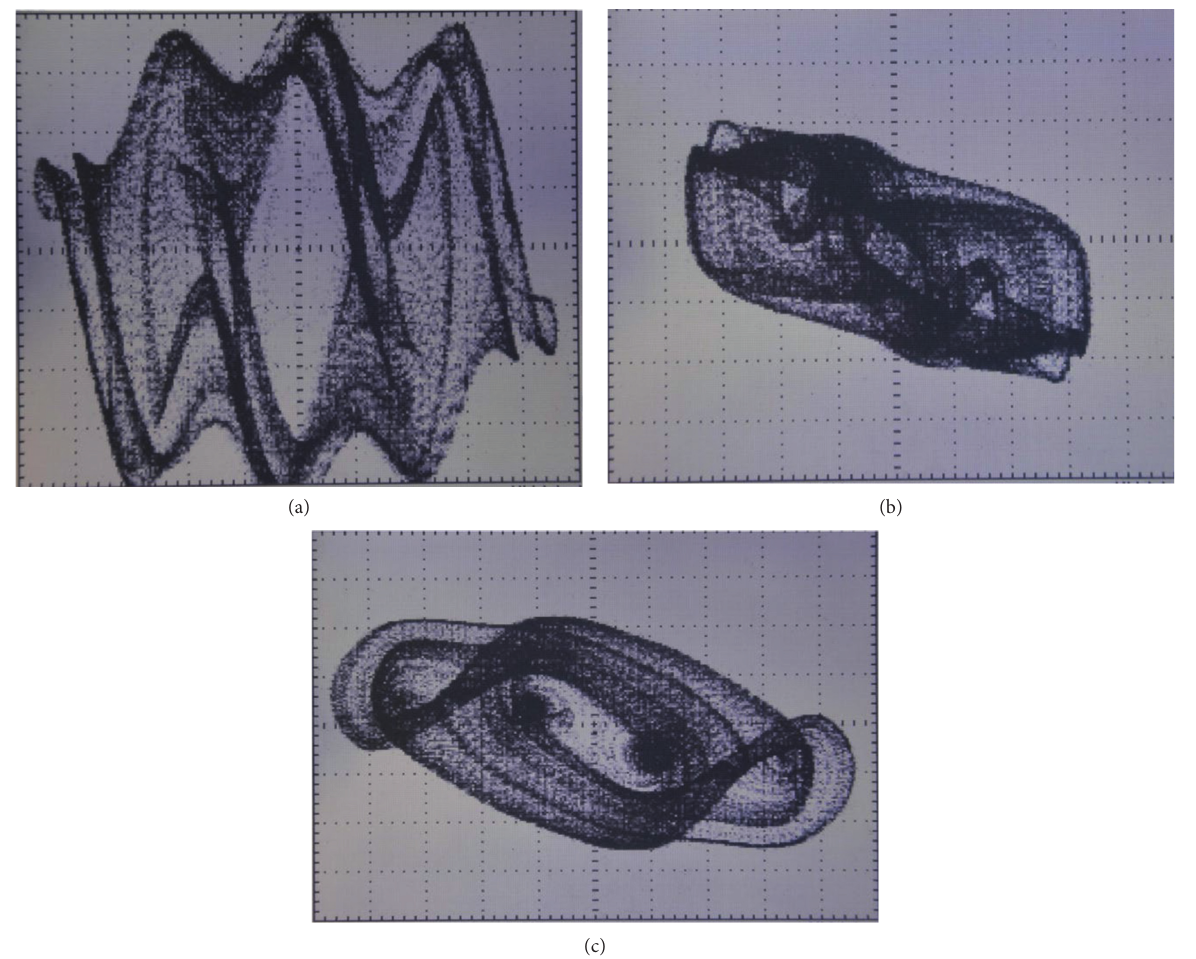
Figure 7: The chaotic attractor of system (4). (a) x - z plane, (b) y - z plane, and (c) x - y